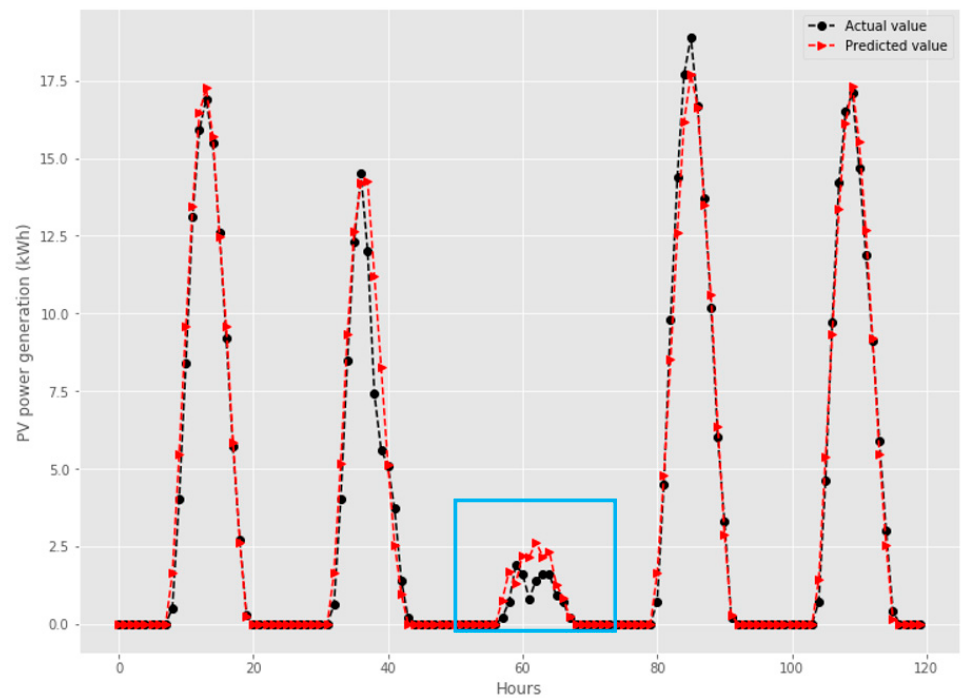
Figure 9. Forecasting result from 8 March 2020 to 12 March 2020 .